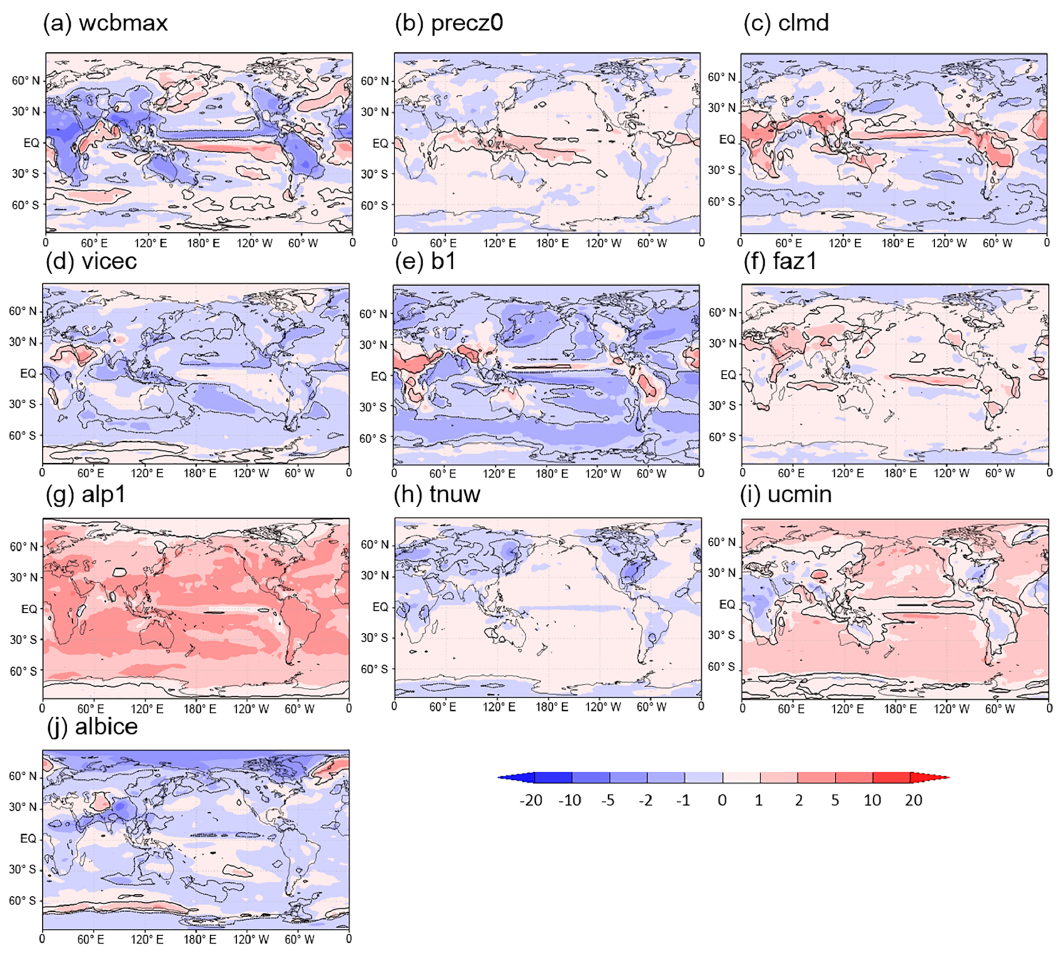
Figure A2. Regression coefficient of the annual mean ISCCP cloud optical thickness on the tuning parameters calculated using the 56 samples of the MIROC5 PPE. The definition of the tuning parameters is shown in Table 1. The tuning parameters are normalized to the range of [0,1]. The black curves indicate the threshold of the statistical significance with the 5%